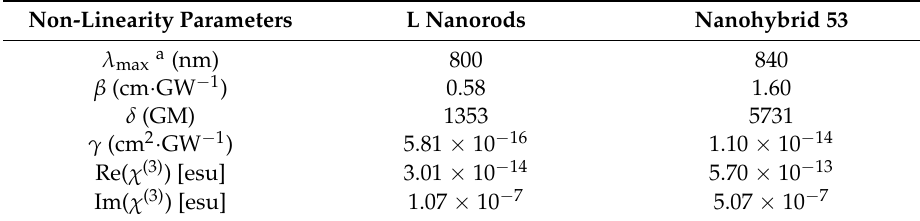
Table 5. Open- and closed-aperture Z-scan measurement data for the nonlinearity parameters of L nanorods and the nanohybrid 53 .